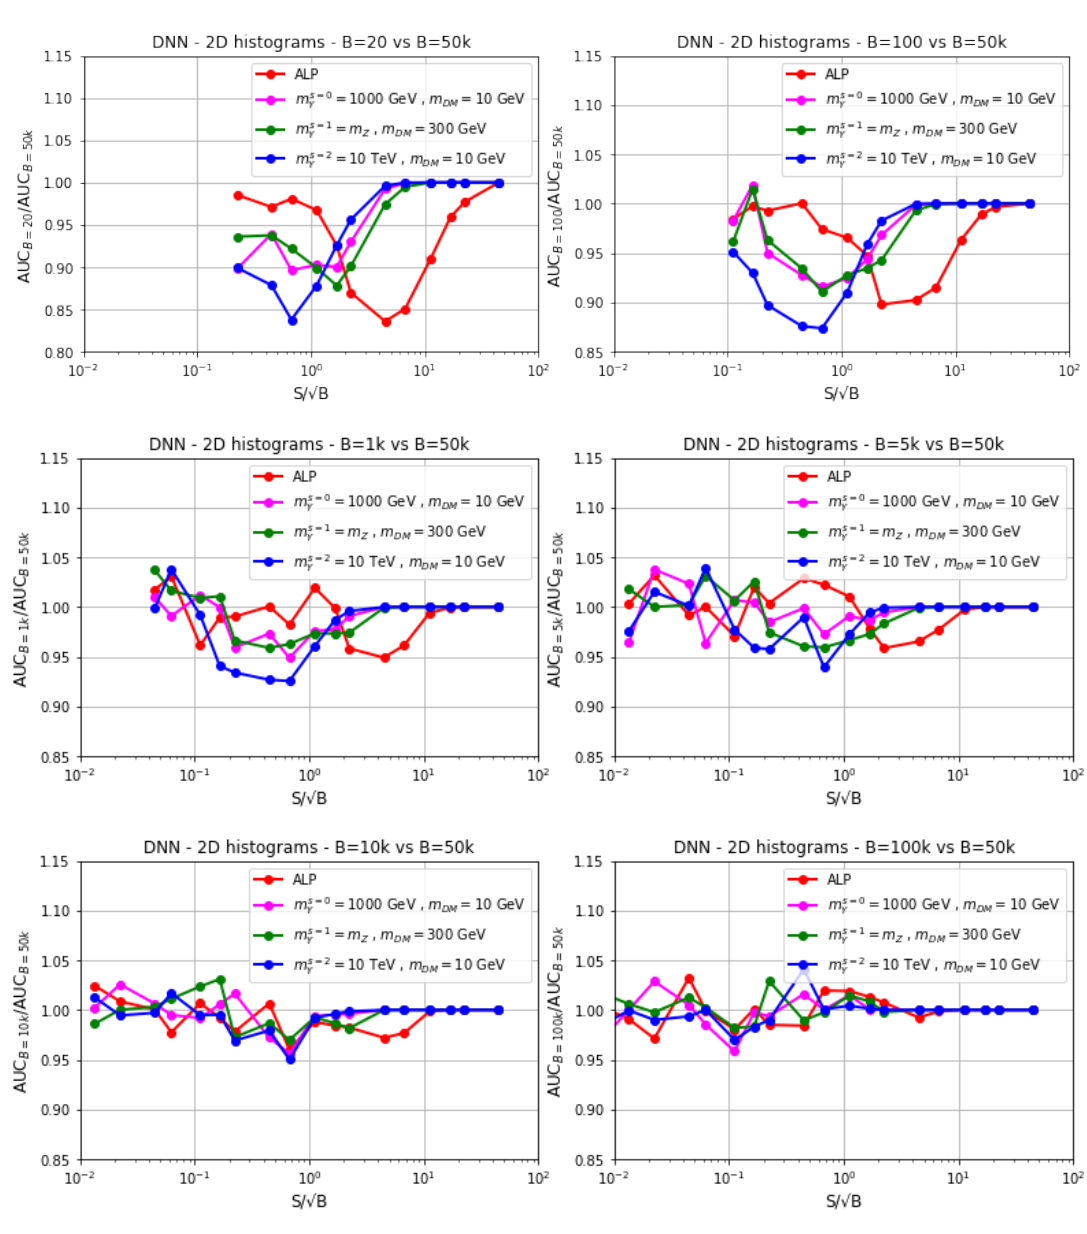
Figure 10: AUCs for histograms constructed with B = 20, 100, 1k, 5k, 10k and 100k, as indicated on the figures, divided by the AUC considering B = 50k, for several benchmark models. Results for the case with B = 50k can be found in Fig. 7. Each model is tested independently in a binary classifier to distinguish new physics plus SM vs SM-only